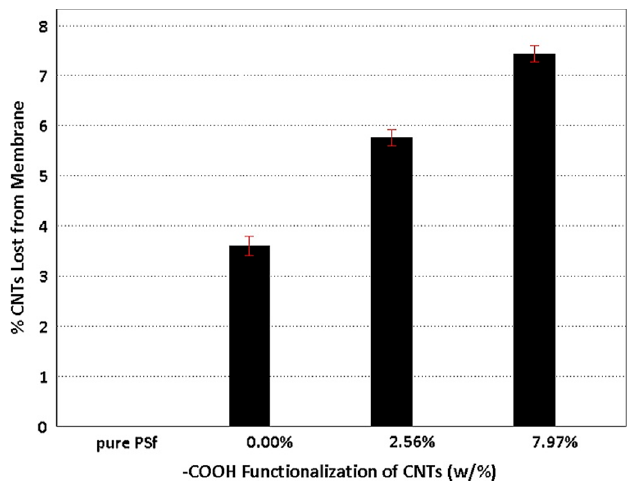
Figure 13. CNTs loss from polymer membranes during precipitation immersion in DIW. With permission [52].